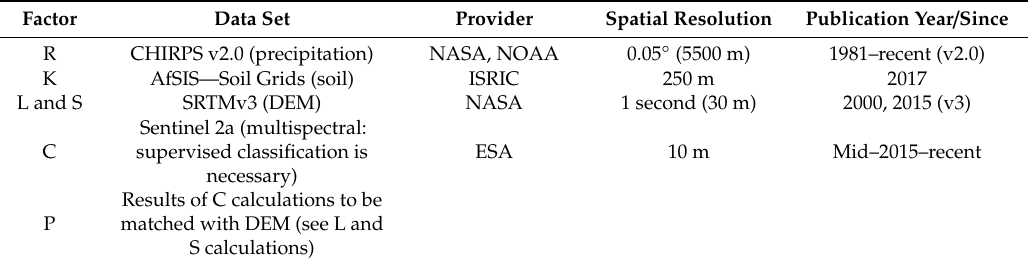
Table 1. Freely available datasets to measure (R)USLE